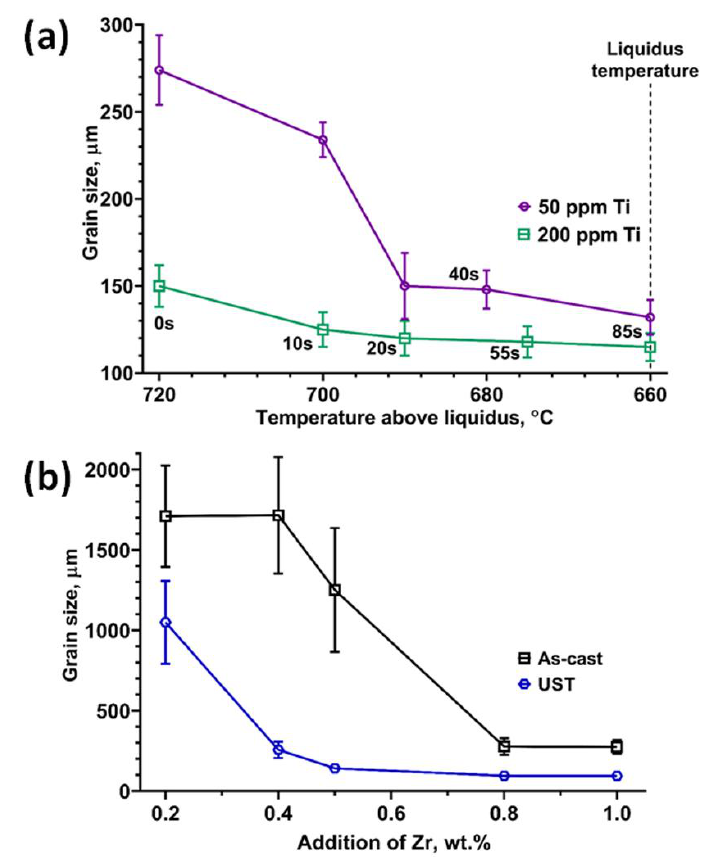
Figure 6. UST terminated above liquidus temperature at specific temperatures from 720 °C to 660 °C in ( a ) Al 3 Ti1B master alloy added at 50 and 200 ppm to pure Al and ( b ) Mg-25Zr master alloy added to commercial purity Mg. The liquidus temperature in Mg-Zr alloys varies from 651 °C to 653 °C in which UST is applied from 750 °C to 660 °C for 60 to 90 s.